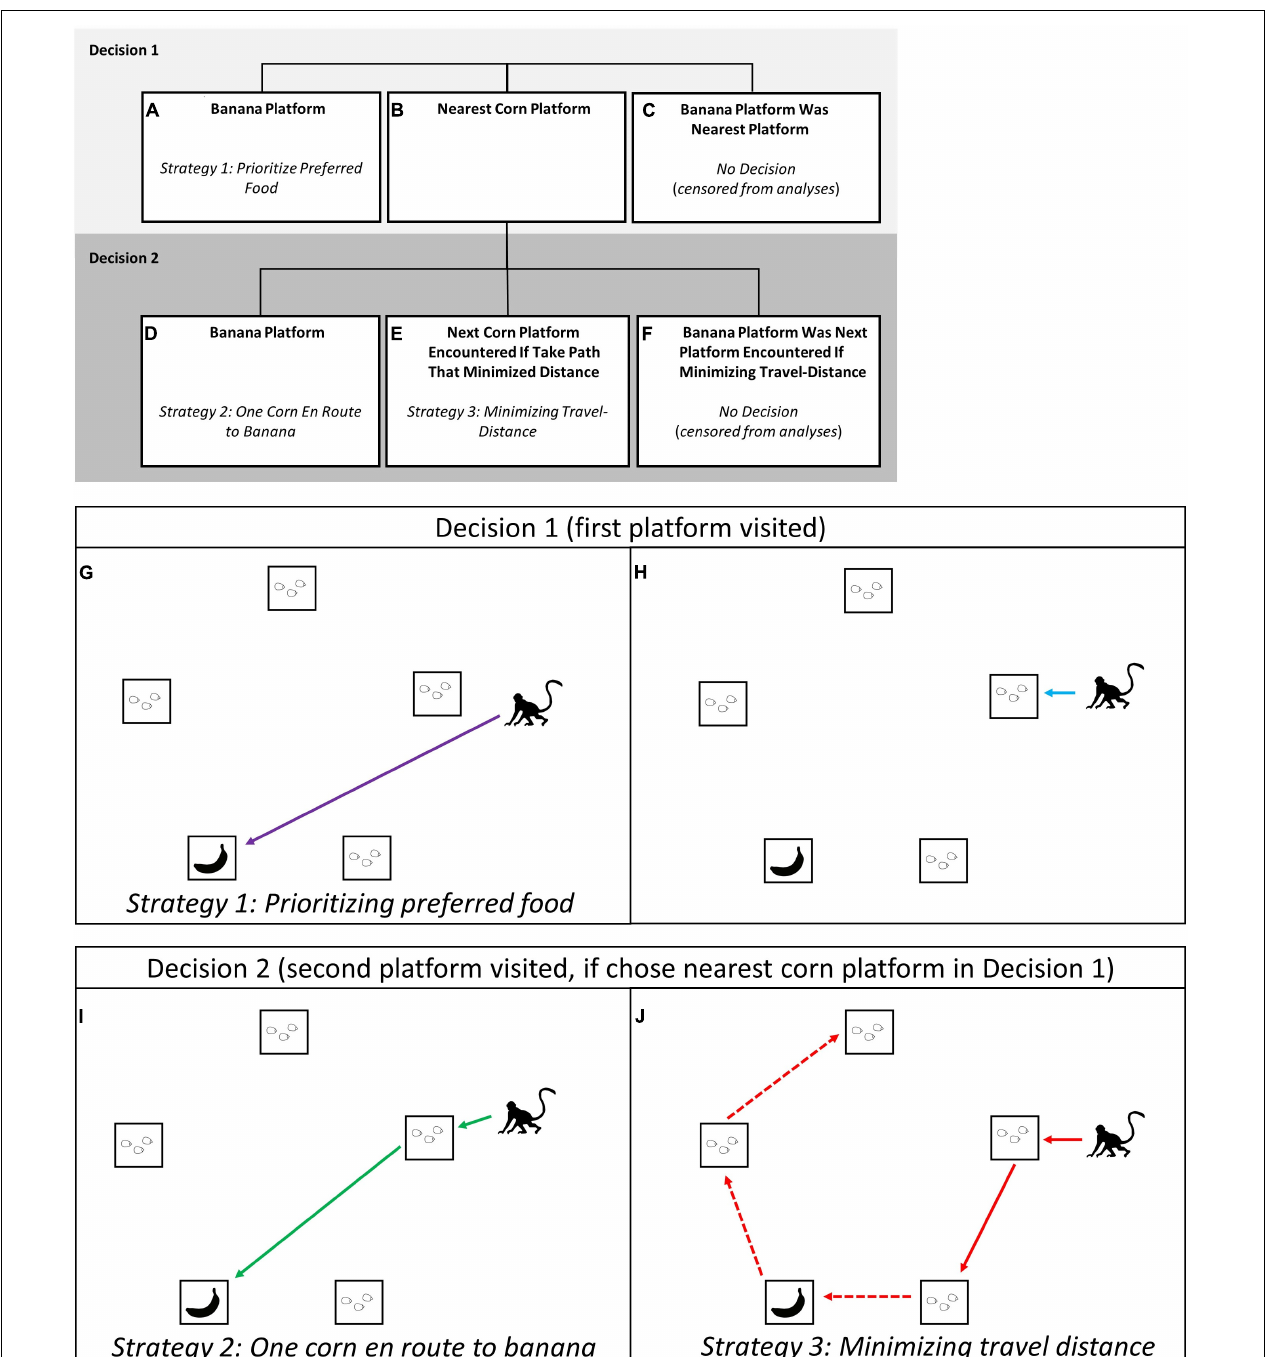
FIGURE 2 | Within this multi-destination foraging experiment, vervet monkeys at Nabugabo, Uganda needed to make two decisions: which platform to visit first [Decision 1: (A,B,G,H) , and which to visit second, Decision 2: (D,E,I,J) ]. Decision 1 was a choice between rushing for the platform with the banana (A,G) , a strategy which prioritized the preferred-food platform, or (B,H) to start at the nearest corn platform. We attempted to bait platforms such that the preferred food (banana) was not the nearest platform; trials in which the banana was on the nearest platform were censored from the analysis because these trials did not require the monkey to choose between minimizing travel distance and prioritizing preferred food (C) . Individuals who chose to visit their nearest corn platform first could then decide if they wanted to (D,I) proceed immediately afterward to the preferred-food platform, or (E,J) travel around the pentagon array in a trajectory that would minimize travel distance, getting the preferred-food when they came to it. Trials in which the platforms were baited such that the preferred-food platform was the second platform encountered when taking the path that minimized travel distance (F) were censored from the analyses because monkeys in these trials did not have to choose between the platform with their preferred food and minimizing travel distance. Note: in box (J) we use the dashed arrow to show the route that a monkey foraging efficiently was expected to take, however, they may not have obtained the rewards on all five platforms if in competition.